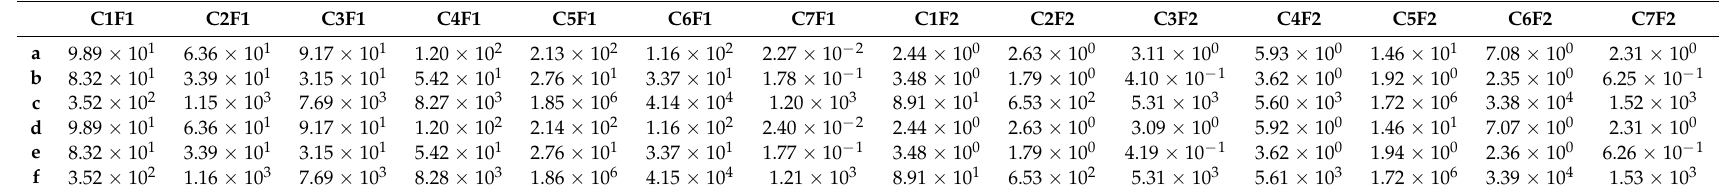
Table 2. Shape descriptor of six